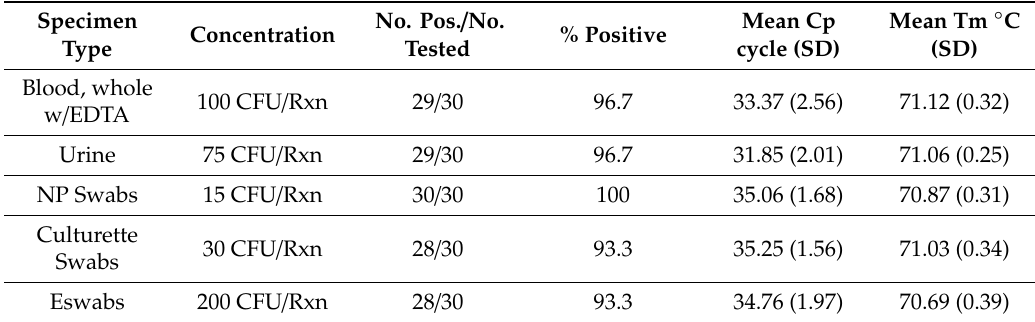
Table 2. Summary Cp and Tm ( ◦ C) results for contrived specimens spiked with C. auris .